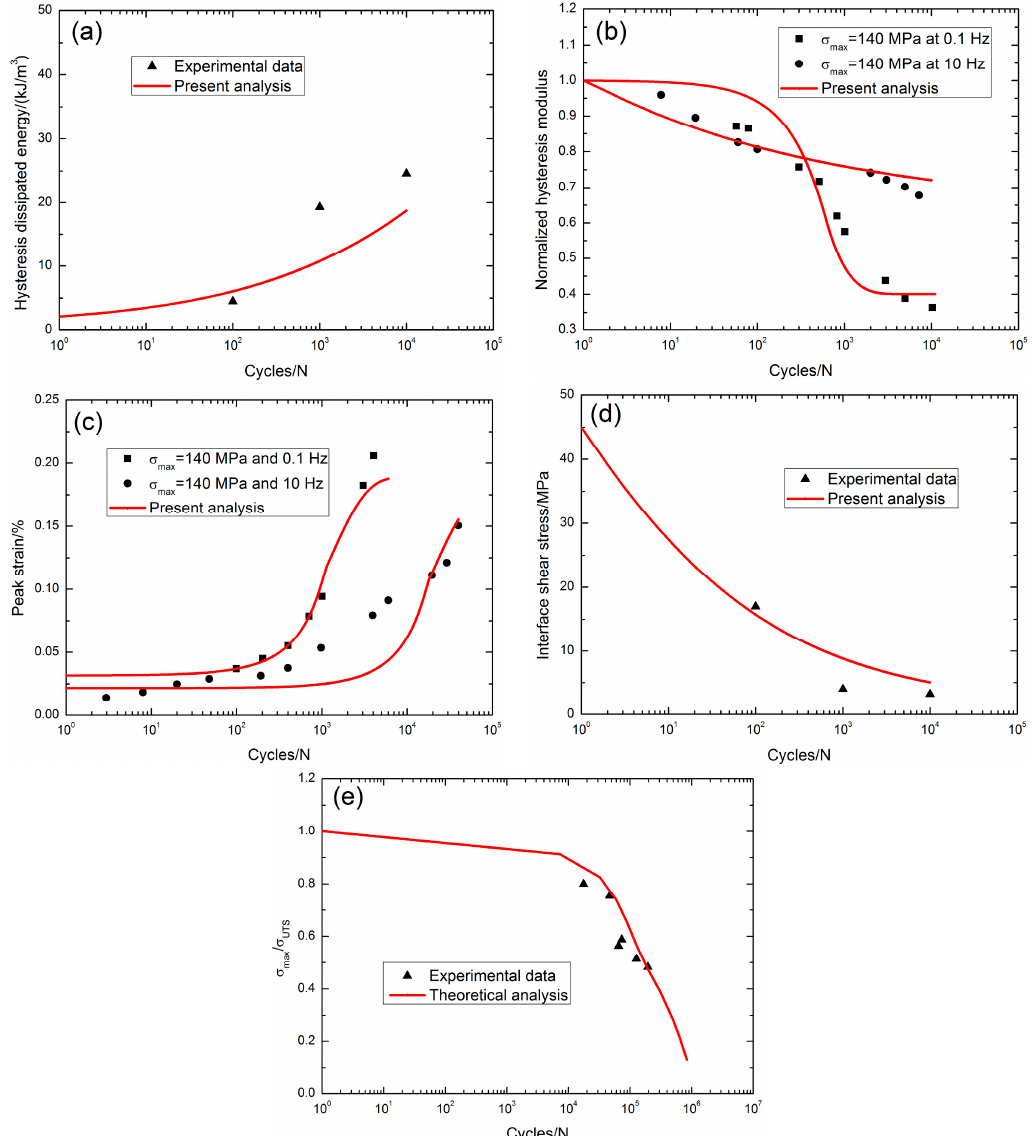
Figure 7. ( a ) The fatigue hysteresis dissipated energy versus applied cycles; ( b ) the normalized fatigue hysteresis modulus versus applied cycles; ( c ) the peak strain versus applied cycles; ( d ) the interface shear stress versus applied cycles; and ( e ) the fatigue life S-N curves of 2D SiC/SiC composite at 1200 °C in steam [5].